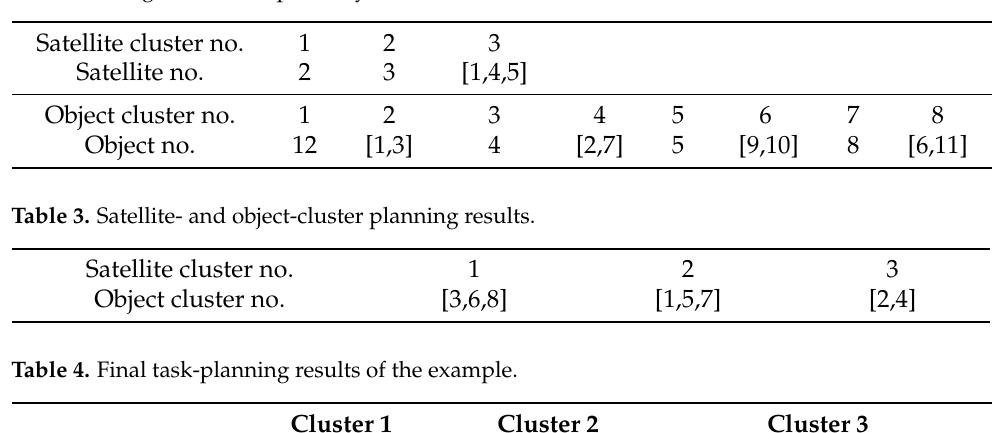
Table 2. Satellite- and object-clustering results using k -means++ and Gaussian mixture model (GMM) soft-clustering method, respectively.